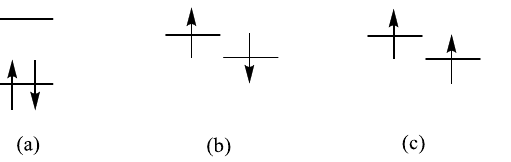
Figure 8. Possible spin configurations: ( a ) closed-shell singlet; ( b ) open-shell singlet; ( c ) triplet.